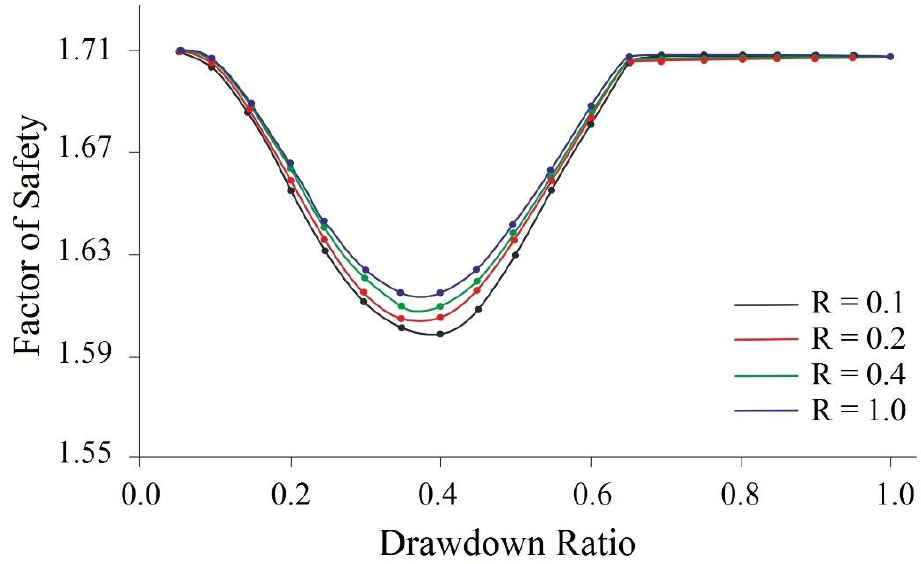
Figure 6. F.S variation versus drawdown ratio regarding R by Morgenstern–Price (LEM) method (Note: R rate is m/day).